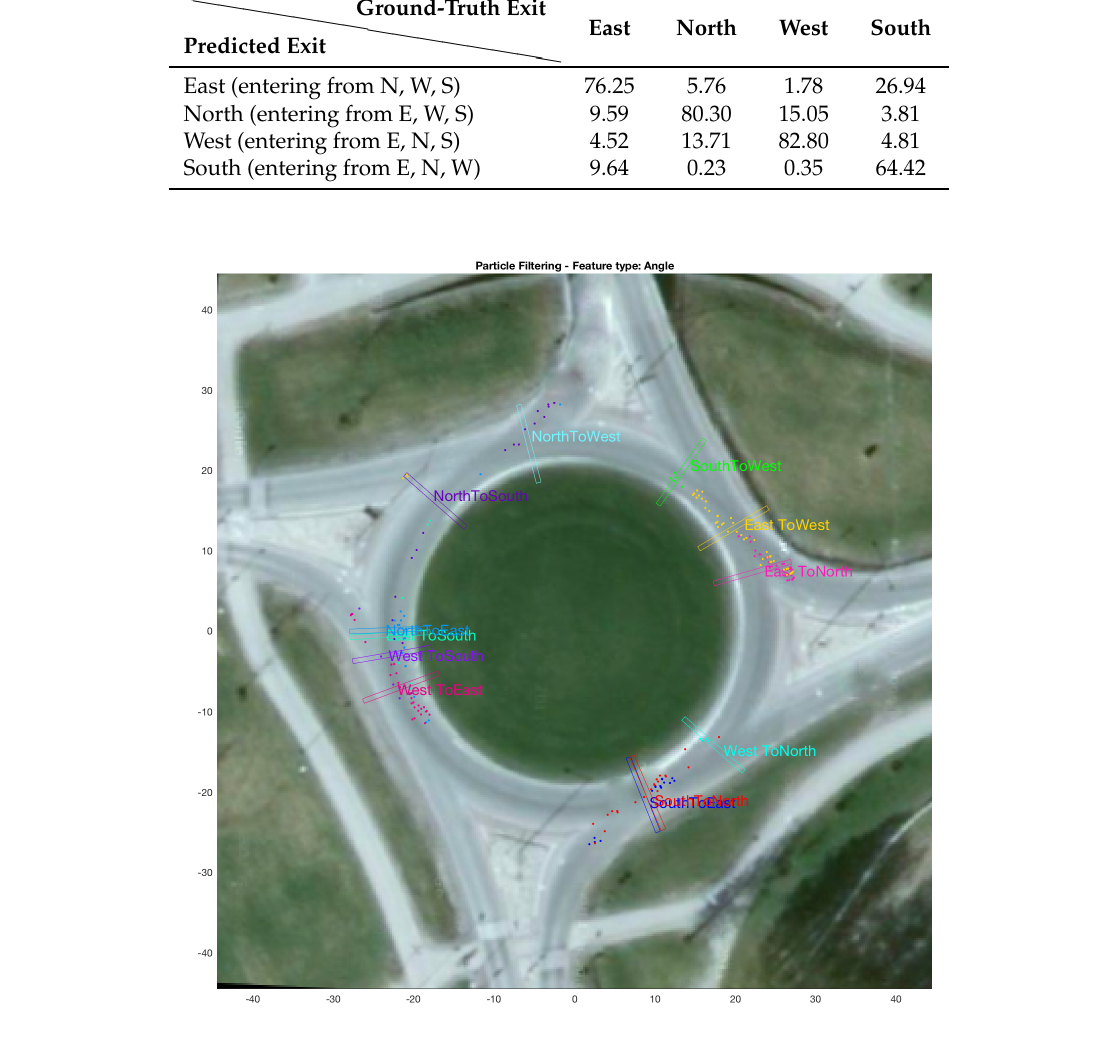
Figure 9. Aggregate results for roundabout dataset using particle filtering. The figure shows (colour-coded for each of the 12 test categories) the locations of the points beyond which 100% correct intention estimation was achieved for each test trajectory (plotted as coloured dots). The figure also shows (for each of the 12 test categories) the location of grid cell closest to the mean location of the points belonging to that category beyond which 100% correct intention estimation was